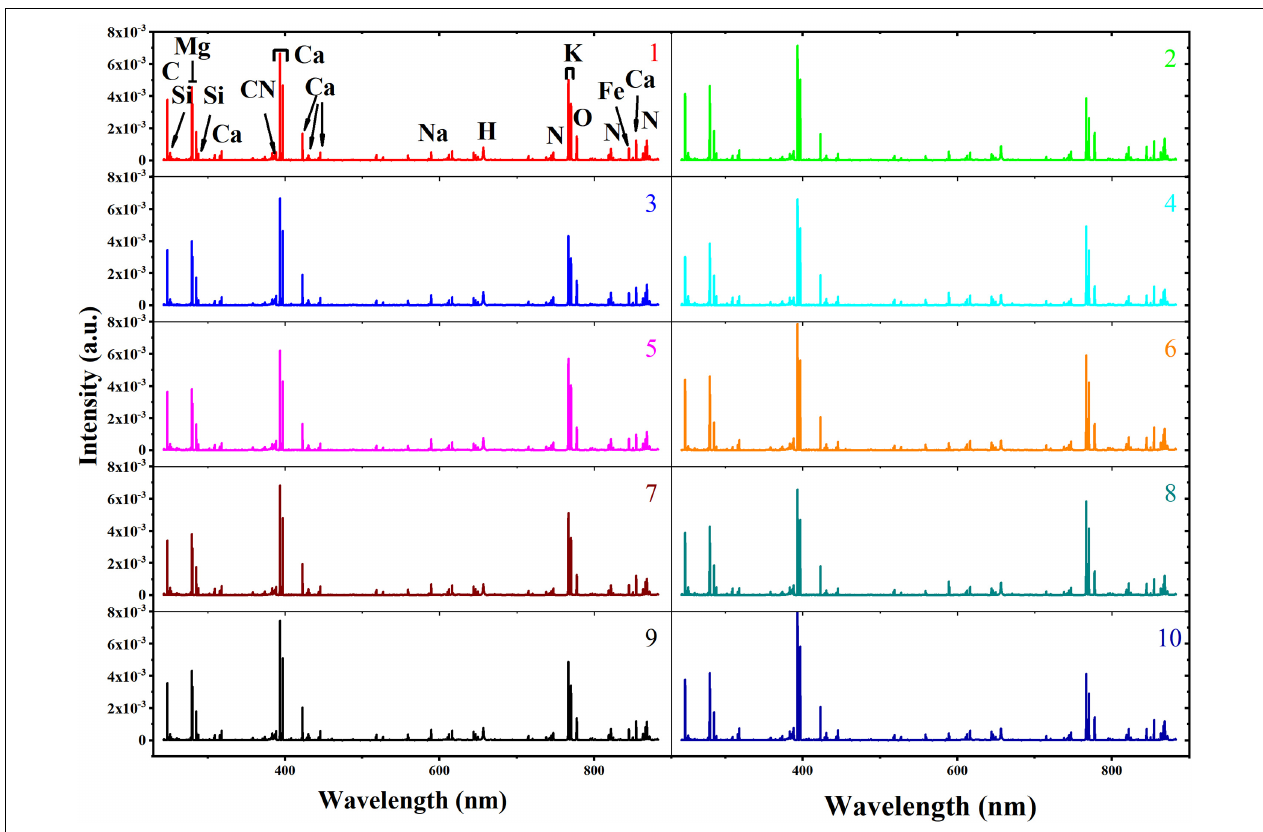
FIGURE 3 | The average spectra of soybean seed samples including different varieties numbered 1–10.